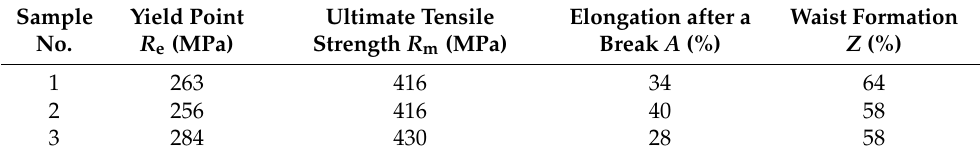
Table 8. Results of the static tensile test of samples from the handy-size bulk carrier 30185 DWT. Sample